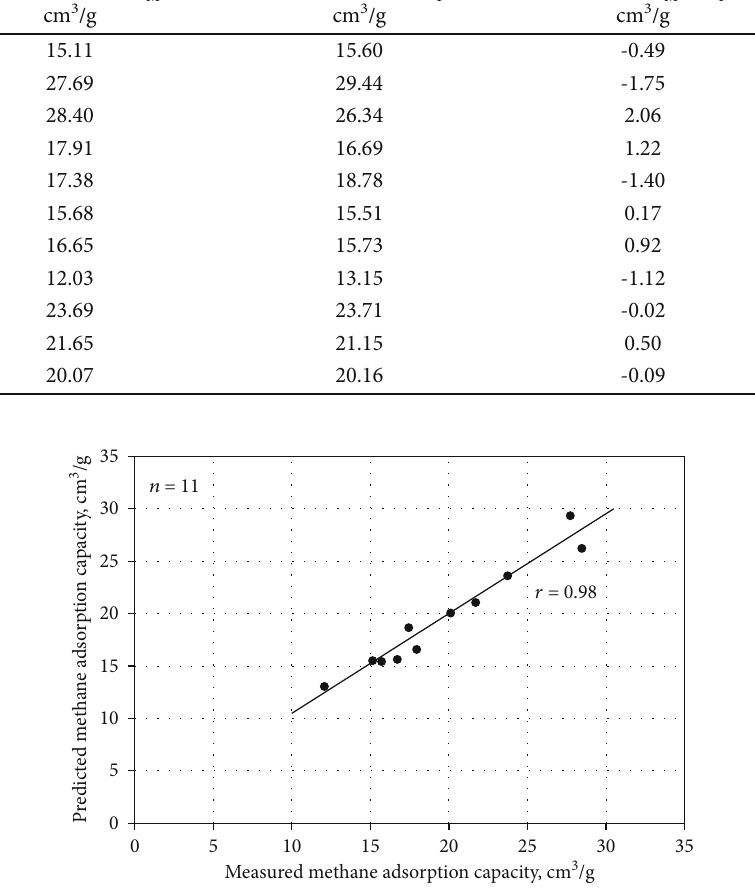
coal in the Xin ’ an coal 1